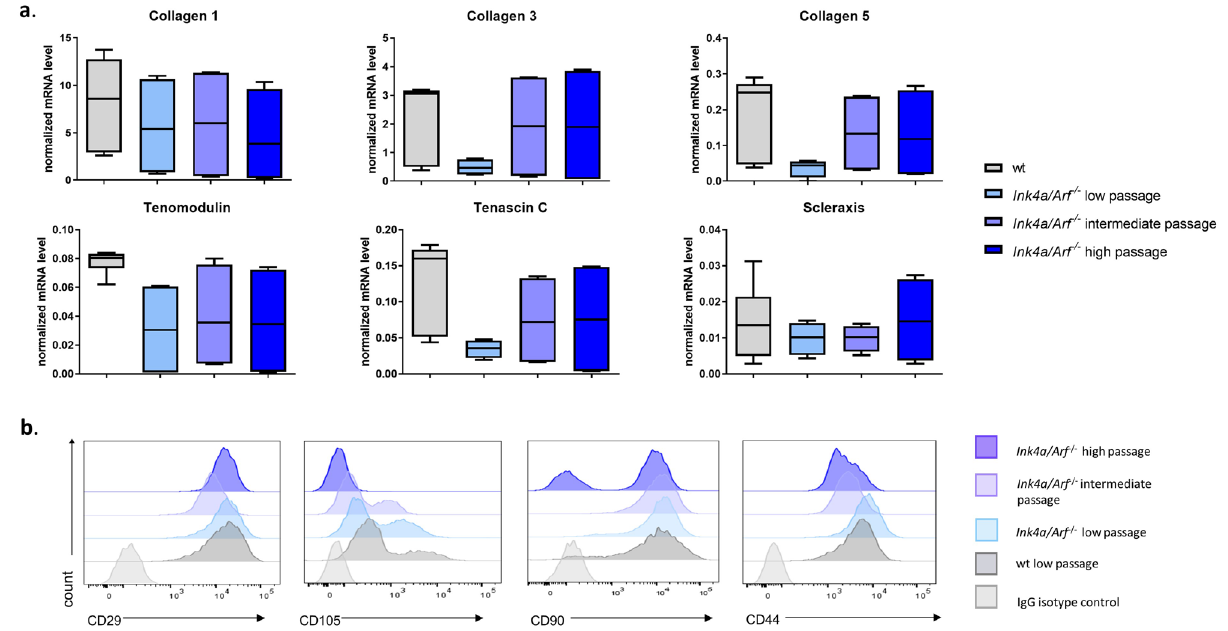
Figure 4. Tenocytes from Ink4a/Arf − / − mice in low, intermediate, and high passage exhibit tenogenic characteristics comparable to tenocytes from wild-type (wt) mice in low passage. ( a ) Box & whiskers plots (mean indicated by the horizontal line and whiskers indicating min–max range) illustrating the qPCR data of tendon markers Col1, Col3, Col5, Scx, Tnmd and Tnc in wt cells and Ink4a/Arf − / − cells from different passages (n = 3 different biological replicates). For mean normalized mRNA levels, s.d. and p -values see Table 1. ( b ) Representative histograms of flow cytometry analysis of CD29, CD105, CD90 and CD44 expression in wt (low passage) and Ink4a/Arf − / − cells (in low, intermediate, and high passages) revealed similar levels of surface markers confirming their tenogenic phenotype (n = 3 different biological